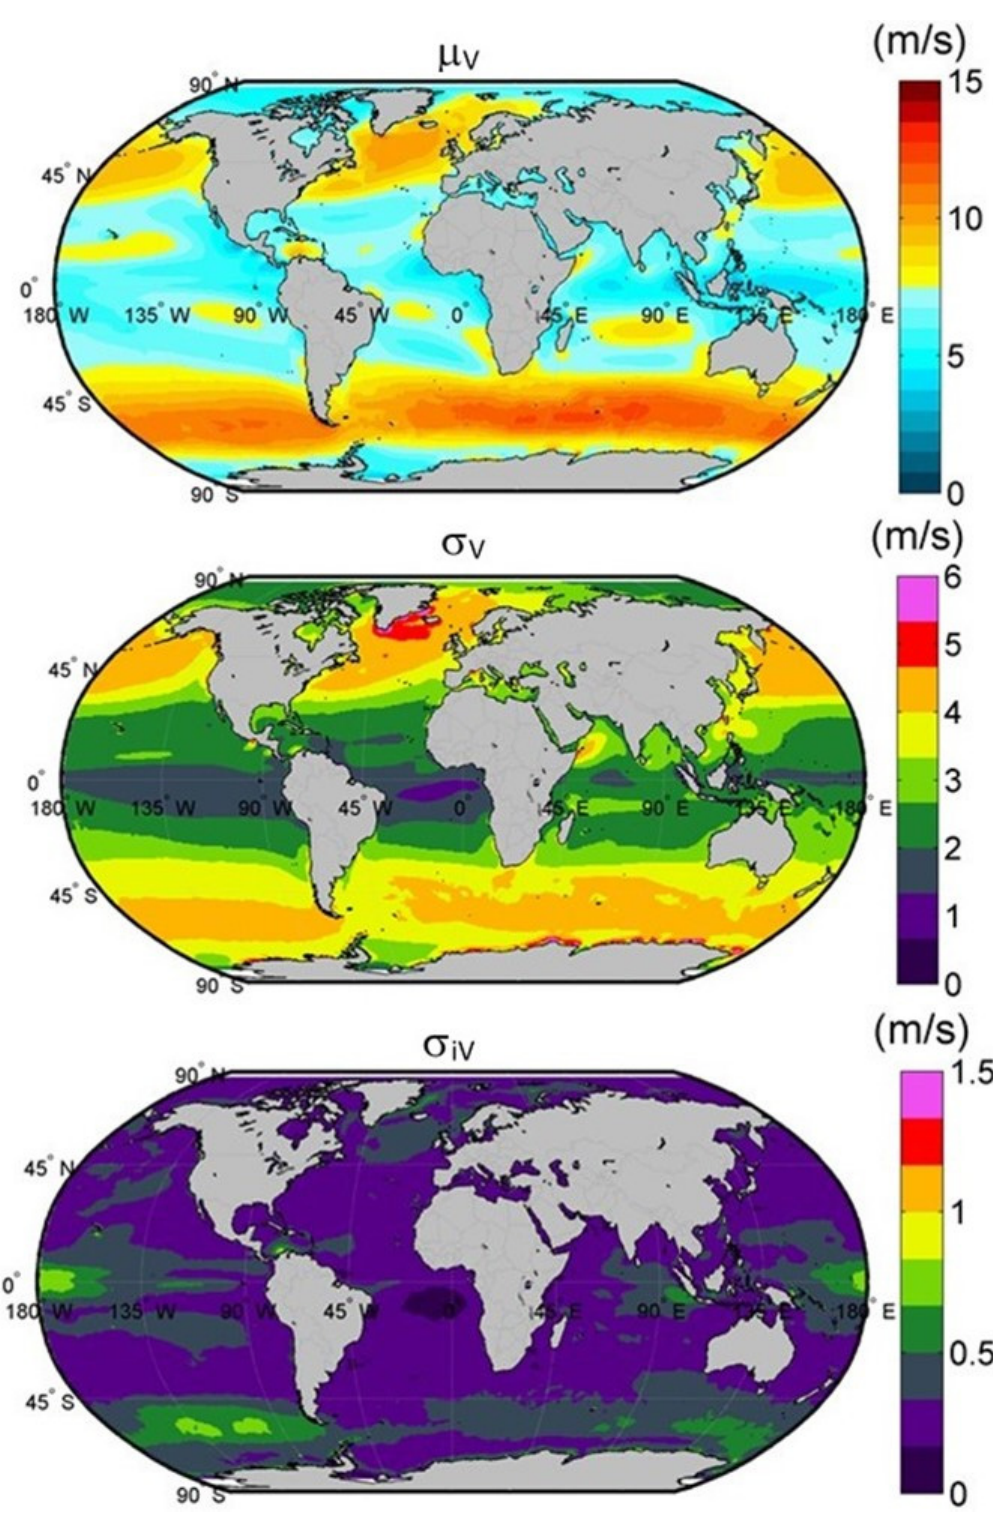
Figure 2. Global distribution of: mean wind velocity, μ V ( top ), standard deviation of wind velocity, σ V ( centre ) and inter-annual standard deviation of mean wind velocity, σ iV ( bottom ).